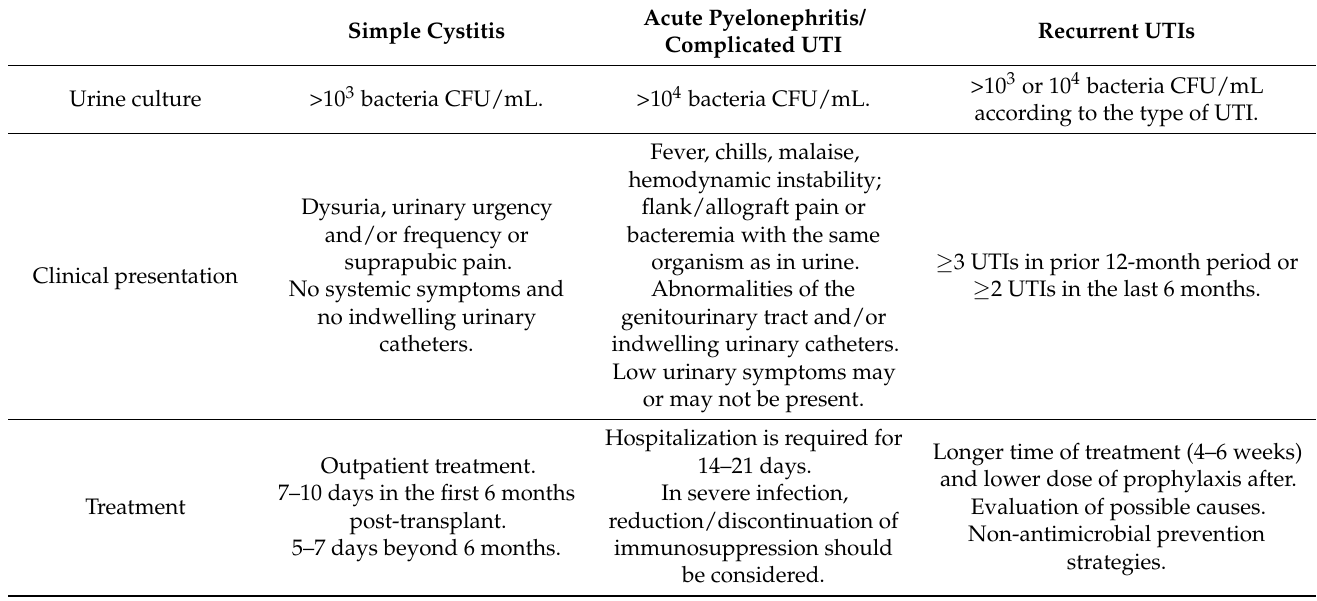
Table 3. Classification of urinary tract infection (UTI) in renal transplant